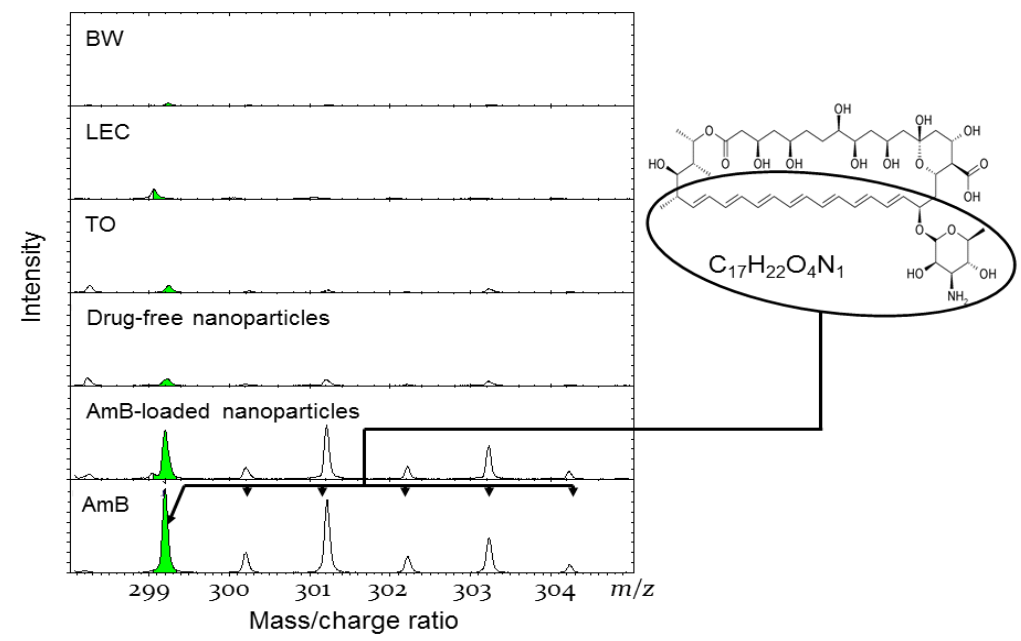
Figure 6. Spectra (m/z) of secondary negative ions obtained from raw material (BW, LEC, AmB and TO) drug-free and AmB-loaded solid lipid